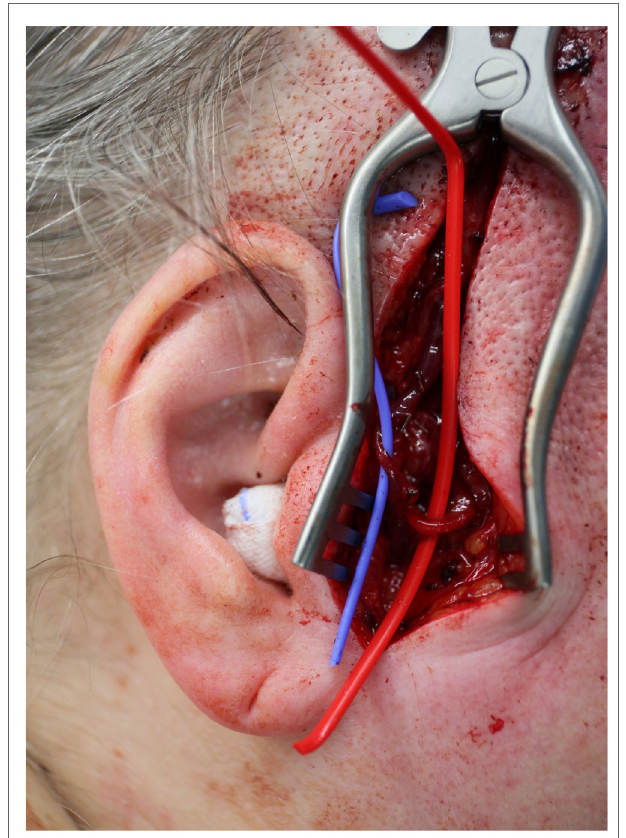
FiGURe 2 | The dissected superficial temporal vessels that will be utilized as recipient vessels .